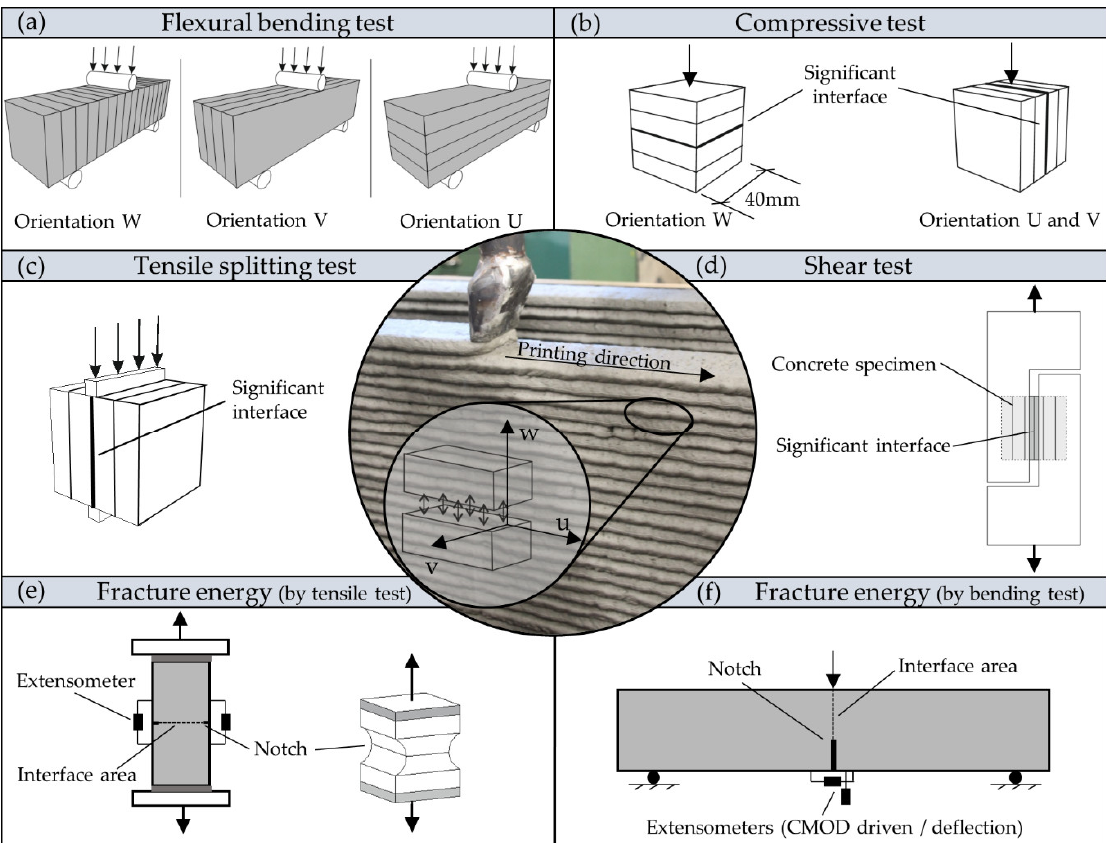
Figure 1. Compilation of different test methods on hardened printed concrete to investigate the mechanical properties during ( a ) flexural stress with 3-point bending tests [15]; ( b ) compressive stress test [15].; ( c ) Tensile test setup with tensile splitting test [11]; ( d ) Shear test setup [28]; determination of fracture energy with ( e ) uniaxial tensile test setup of dog-bone shaped specimen [24] and cylindrical specimen [22]; ( f ) 3-point bending tes.t setup [29].